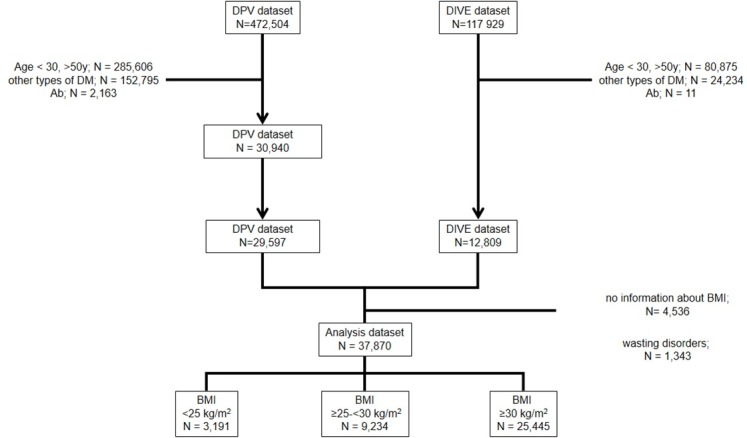
Patient flow.DM: diabetes mellitus; Ab: beta-cell autoantibodies; wasting disorders: malignancies, tuberculosis, chronic pancreatitis, alcoholism; BMI: body mass index.